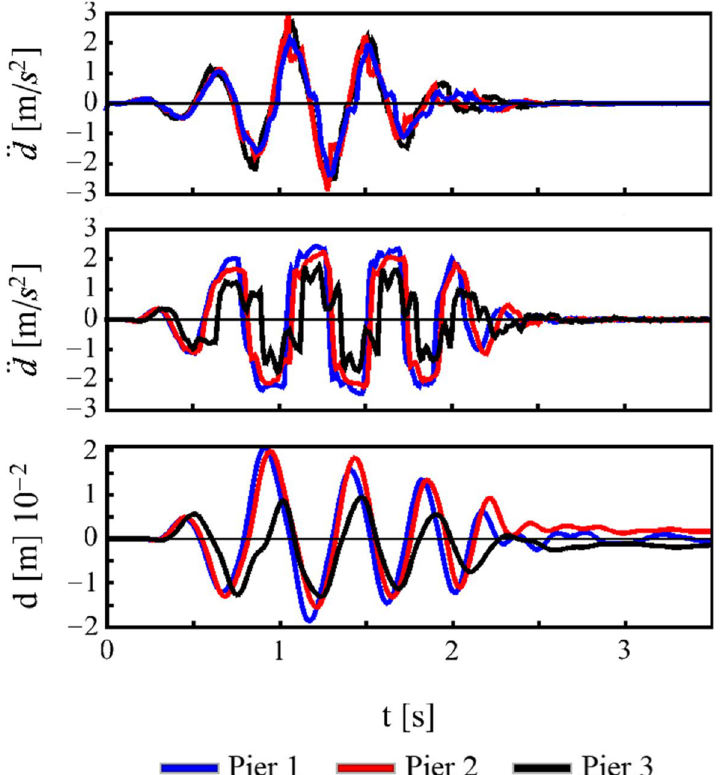
Fig. 9 Time history of the acceleration at the soil-bedrock interface (top) and pier base (middle) and of the displacement at the pier top (bottom), in the direction of the longitudinal axis of the bridge, for a predominant frequency of the input signal f q 2.2 Hz and nonlinear behavior of =